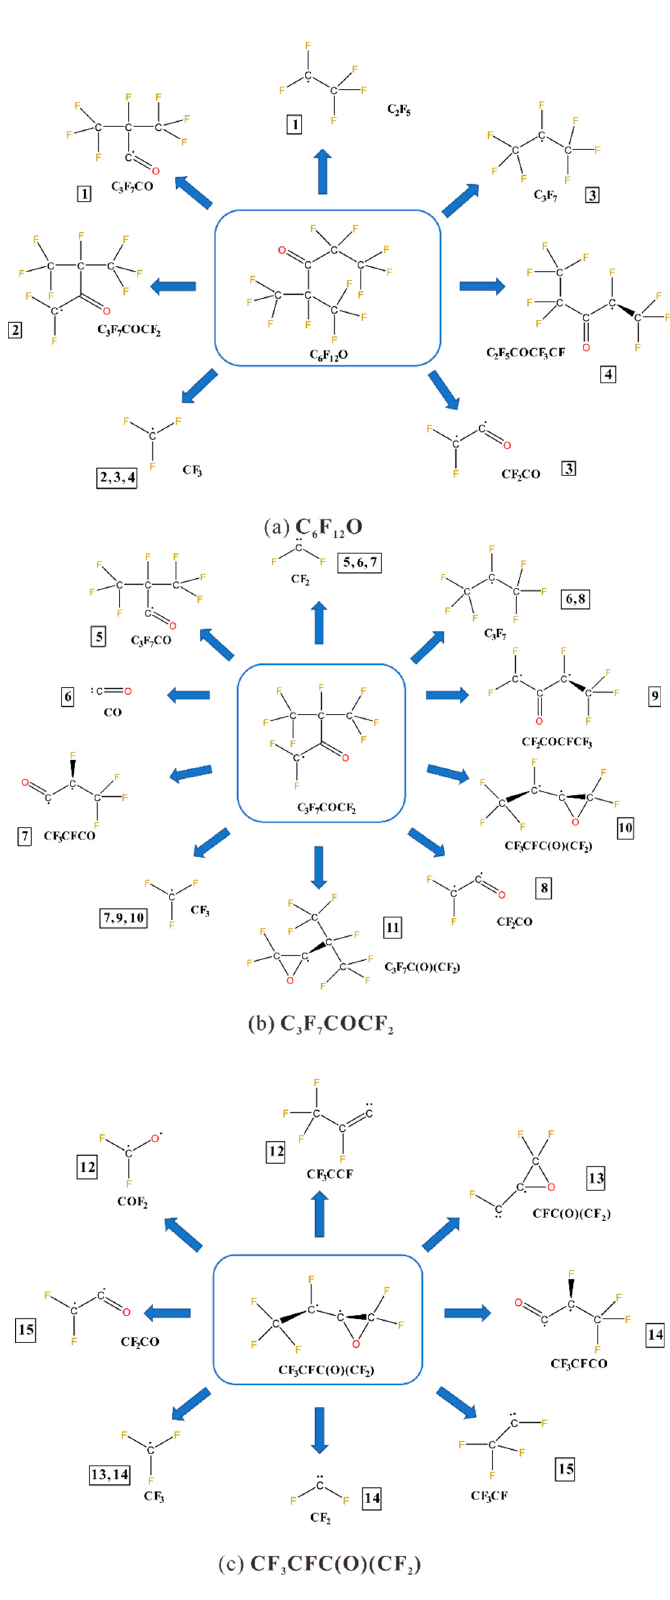
Figure 5. The proposed decomposition mechanisms of C 6 F 12 O/CO 2 [52].